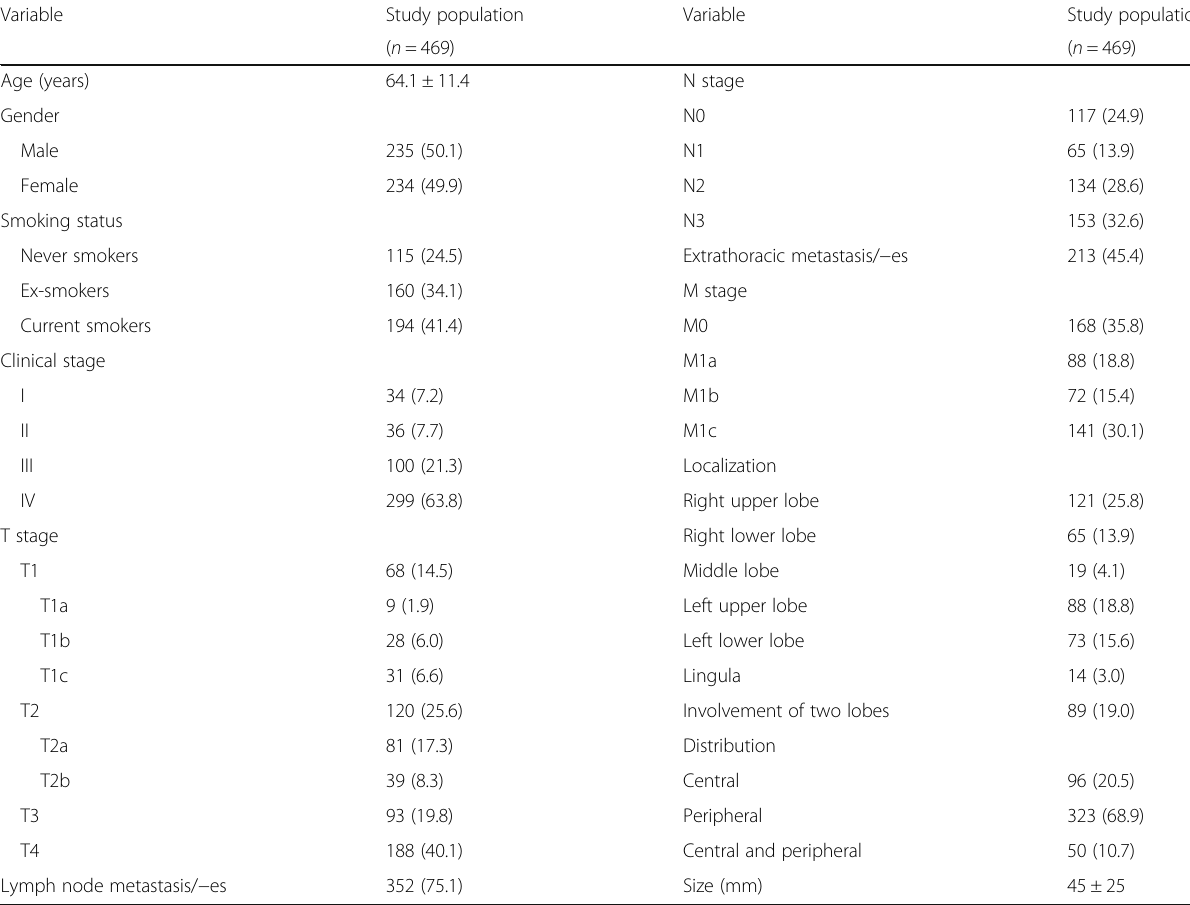
Table 1 Patient